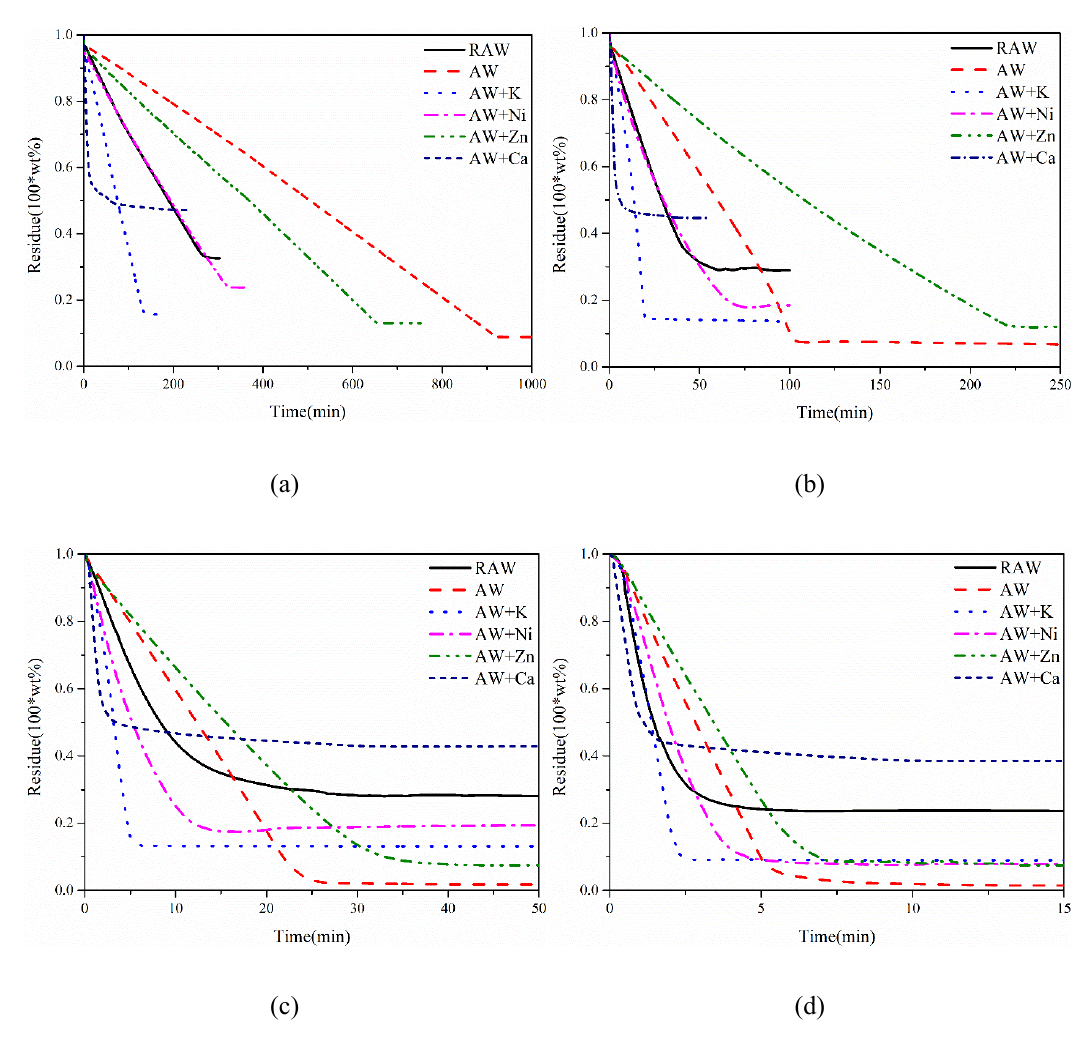
Figure 2. E ff ects of di ff erent metal chlorides on AW char gasification. ( a ) 800 ◦ C;( b ) 900 ◦ C; ( c ) 1000 ◦ C; Figure 2. Effects of different metal chlorides on AW char gasification. ( a ) 800 °C;( b ) 900 °C; ( c ) 1000 °C; ( d ) 1100 ◦ ( d ) 1100 °C.